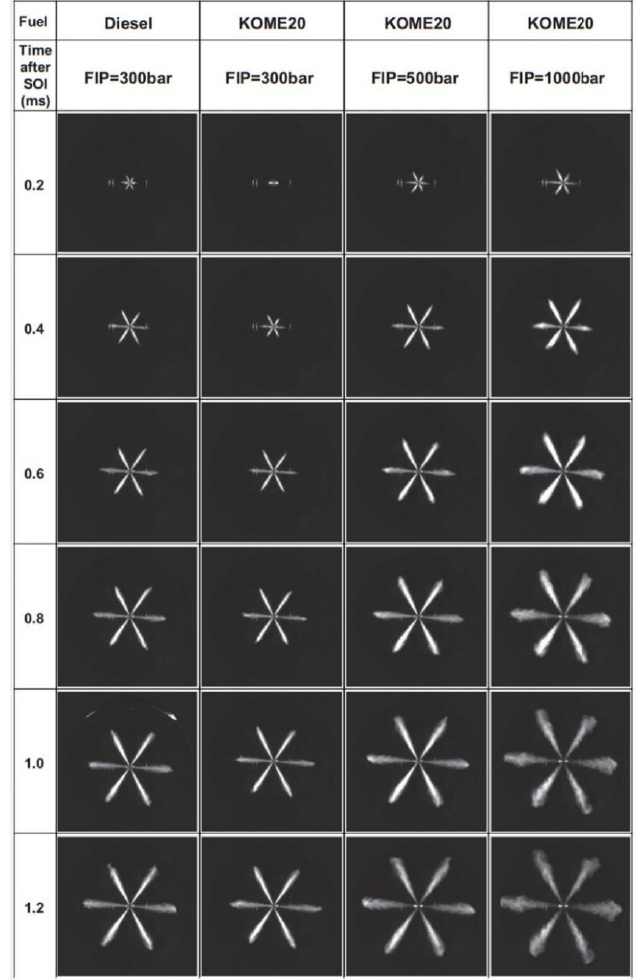
Figure 10. Processed spray profiles of Karanja biodiesel for various time duration. Reprinted with permission from Ref. [98].